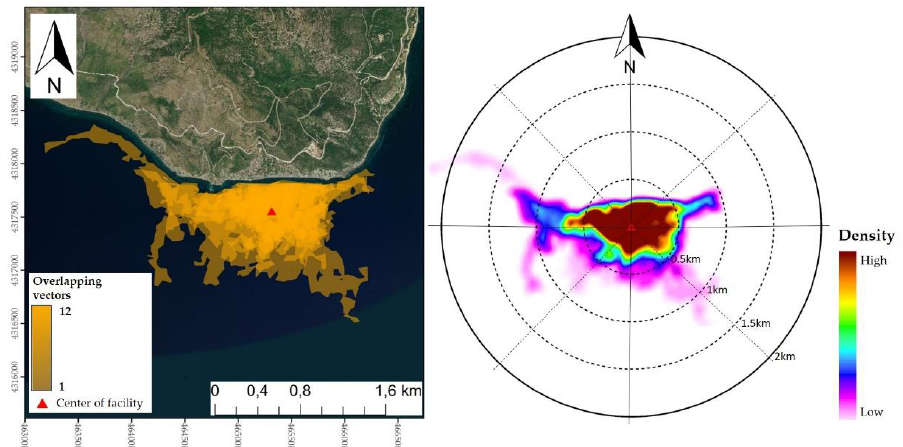
Figure 14. Biogenic oil films detected during the study period (2019–2020) in Kratigos (Site 1). The overlapping vectors ( left ) were used to create the density map ( right ). Both images show the spatial extend of the film in the surrounding area.